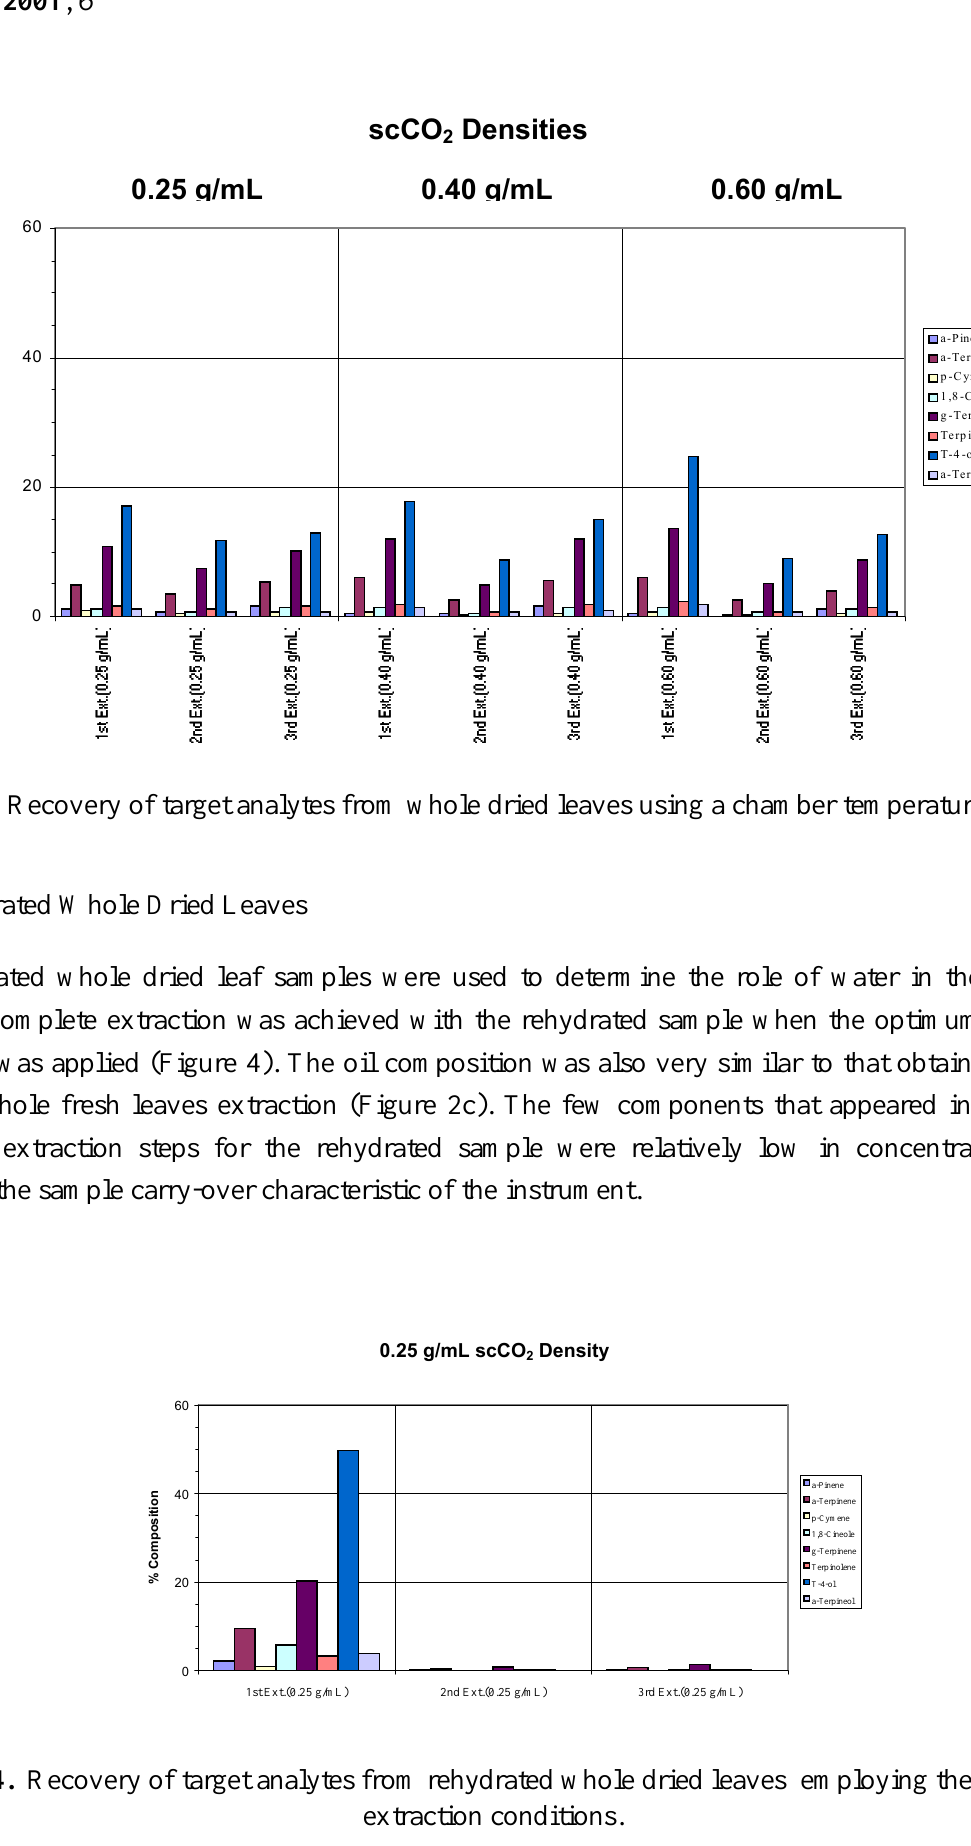
Figure 4. Recovery of target analytes from rehydrated whole dried leaves employing the optimum extraction conditions.